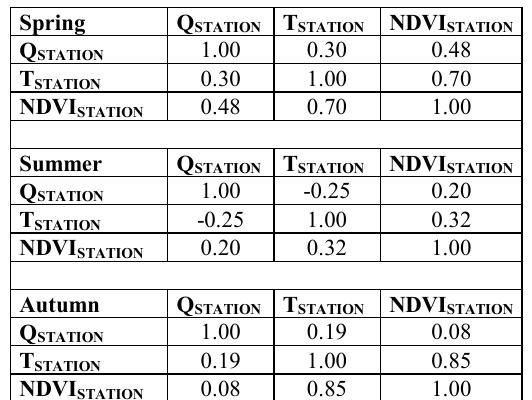
allocation becomes less accurate.